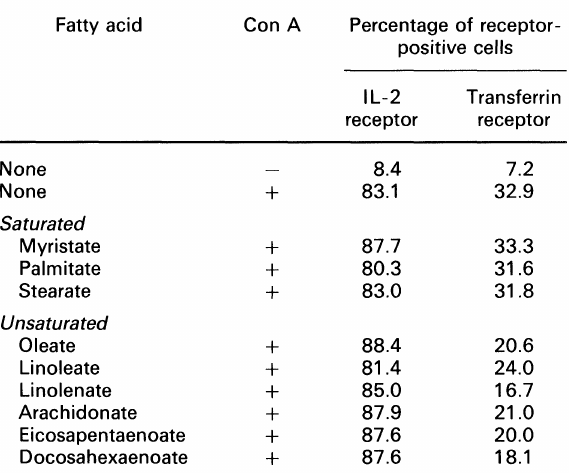
Rat lymph node lymphocytes were cultured in the absence or presence of Con A and 100 #M fatty acid-albumin complexes. After 48 h the cells were collected, washed and incubated with monoclonal antibodies to the IL-2 receptor or transferrin receptor. After washing, the cells were incubated with RAM-FITC. After further washing, the cells were examined by FACS analysis. Data are the percentage of cells staining positive for each receptor, and are for a single, representative, cell